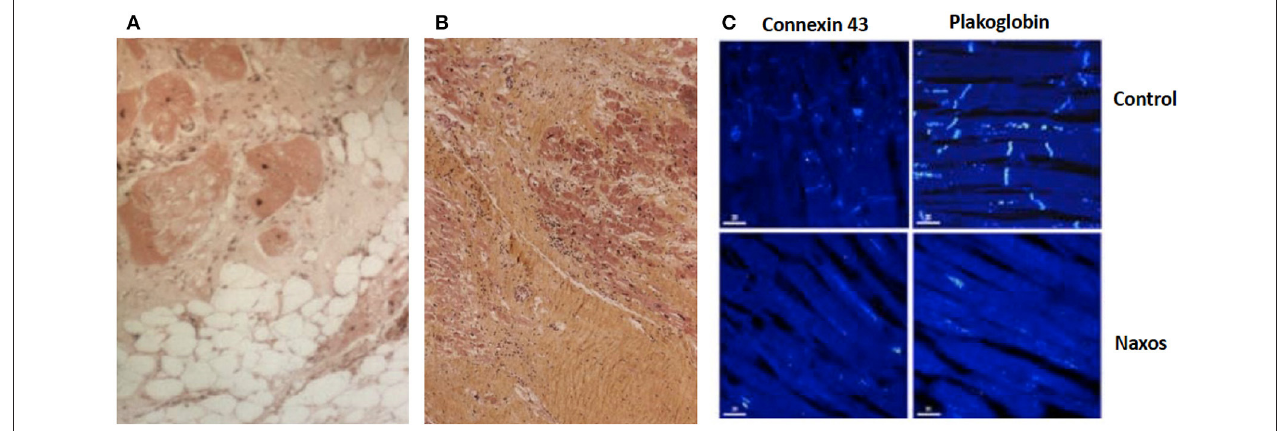
FIGURE 8 | Surgical sample from the anterior wall of the right ventricle of a 19-year-old patient with Naxos disease. Surviving myocardial fibers with some vacuolization, surrounded by fibrosis (haematoxyline-eosine-stained, magnification x 100) (A). Postmortem samples from the left ventricle of a patient with Naxos disease, who died suddenly at the age of 20 years. Myocardial loss with replacement fibrosis and lymphocyte infiltrates (haematoxylin-eosin-stained sections) (B). On confocal microscopy images (same patient) of the left ventricle, there is diminished signal of plakoglobin and connexin 43 at intercellular junctions